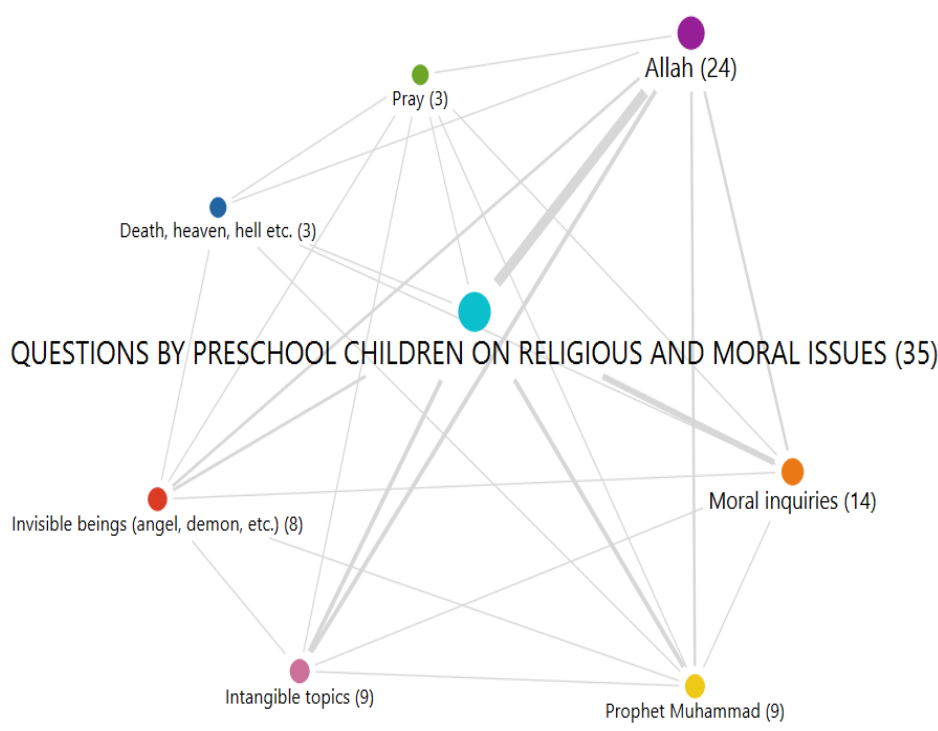
Figure 2. Questions asked by preschool children on religious and moral issues.